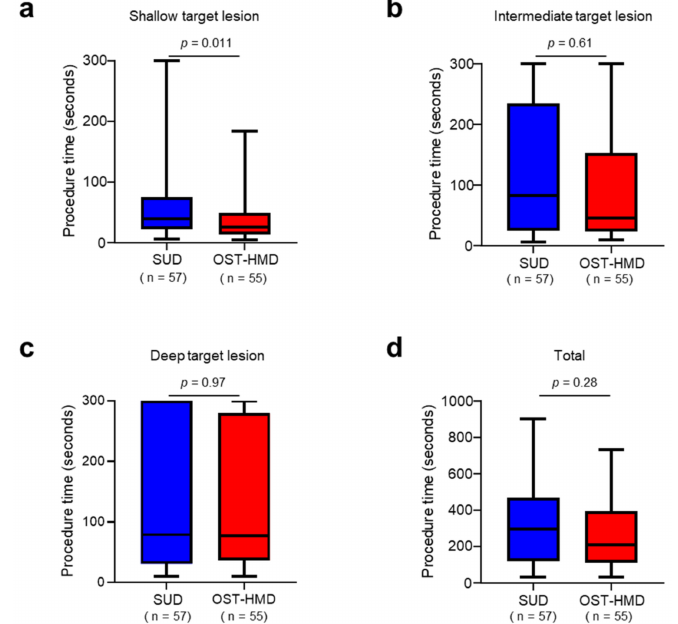
Figure 4. Box-and-whisker plot for the procedure time in the SUD group and the OST-HMD group for the shallow target lesion ( p = 0.011) ( a ), the intermediate target lesion ( p = 0.61) ( b ), and the deep target lesion ( p = 0.97) ( c ). Total procedure time is shown in ( d ) ( p = 0.28). p value was calculated using